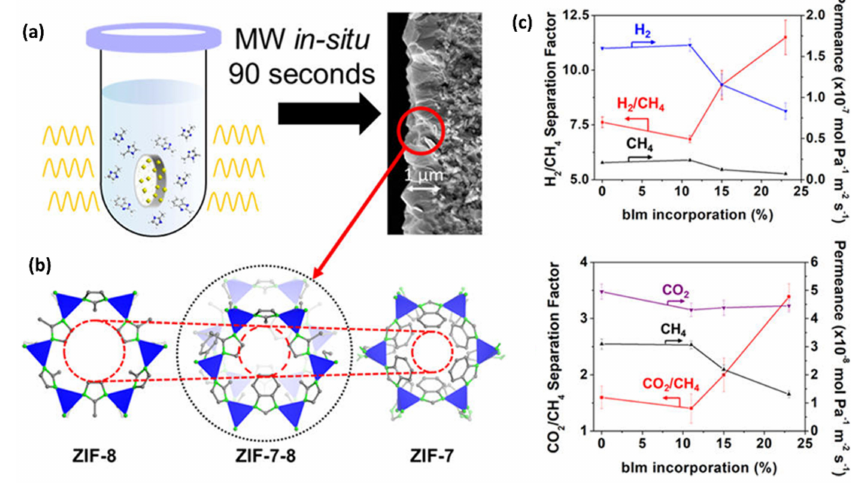
Figure 15. ( a ) Schematic illustration for the microwave-assisted in situ synthesis of mixed linker ZIF-7-8 membranes. ( b ) comparison of effective pore aperture of ZIF-8, ZIF-7, and mixed linker ZIF-7-8. ( c ) Effect of bIm incorporation on H 2 /CH 4 and CO 2 /CH 4 separation performances of ZIF-7-8 membranes